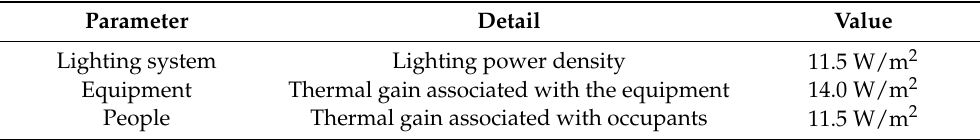
Table 3. Nominal values of the main simulation parameters